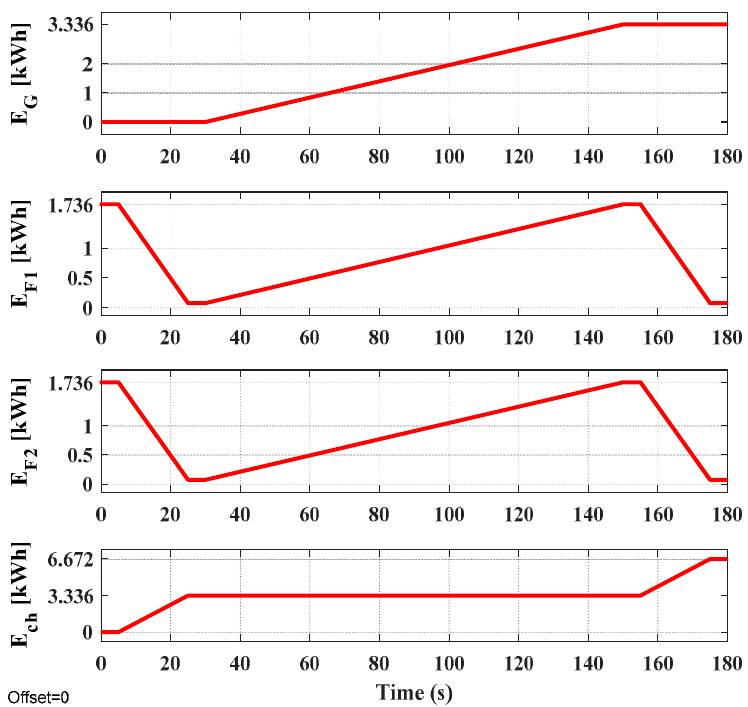
Figure 18. Simulation results for the electric energy of grid, FES1, FES2, and charger.